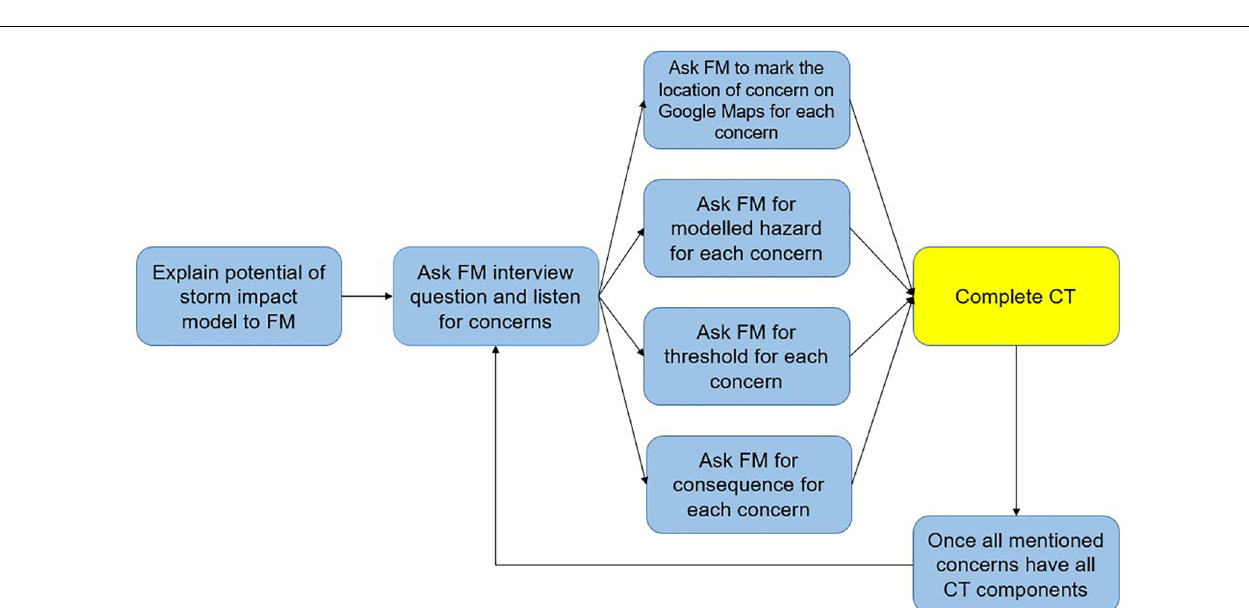
FIGURE 3 | Consequence Threshold (CT) data collection process with facility manager (FM) interviewees (Image: authors).